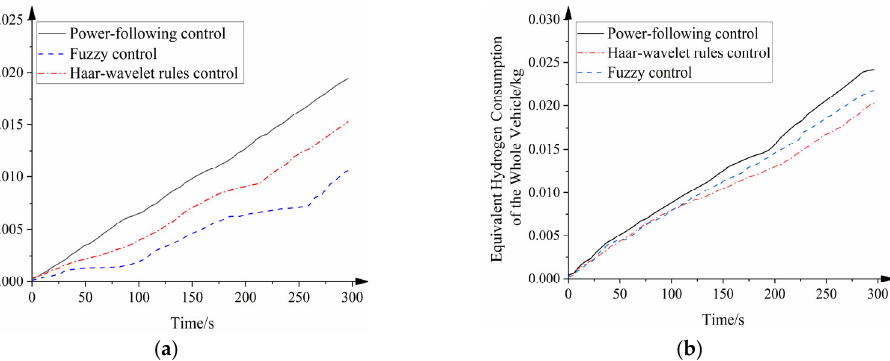
Figure 21. ( a ) Comparison of the PEMFC; ( b ) comparison of the equivalent hydrogen consumption of the whole vehicle.